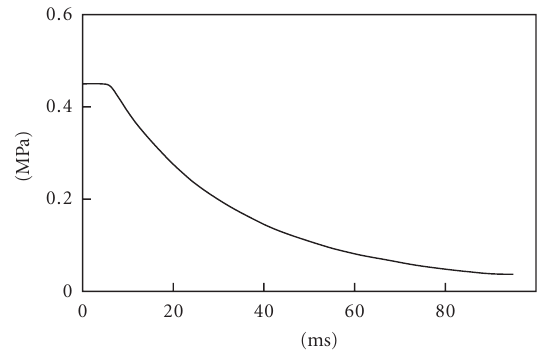
Figure 11: Total pressure of the air flow at the reactor entrance.